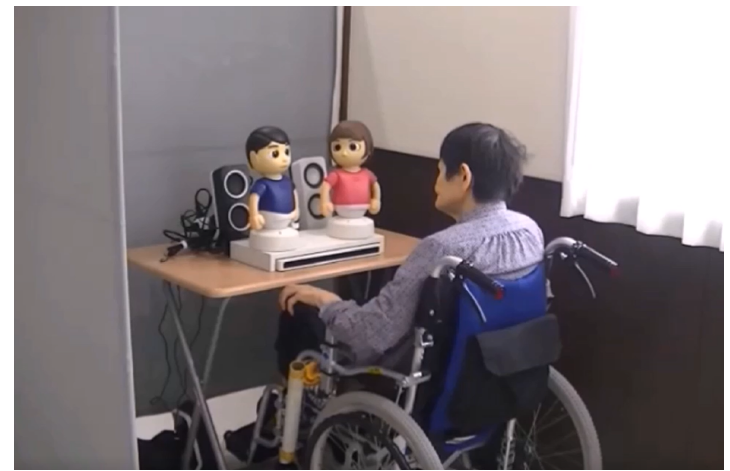
Figure 5. Twin-Robot dialogue system that talks with an elderly